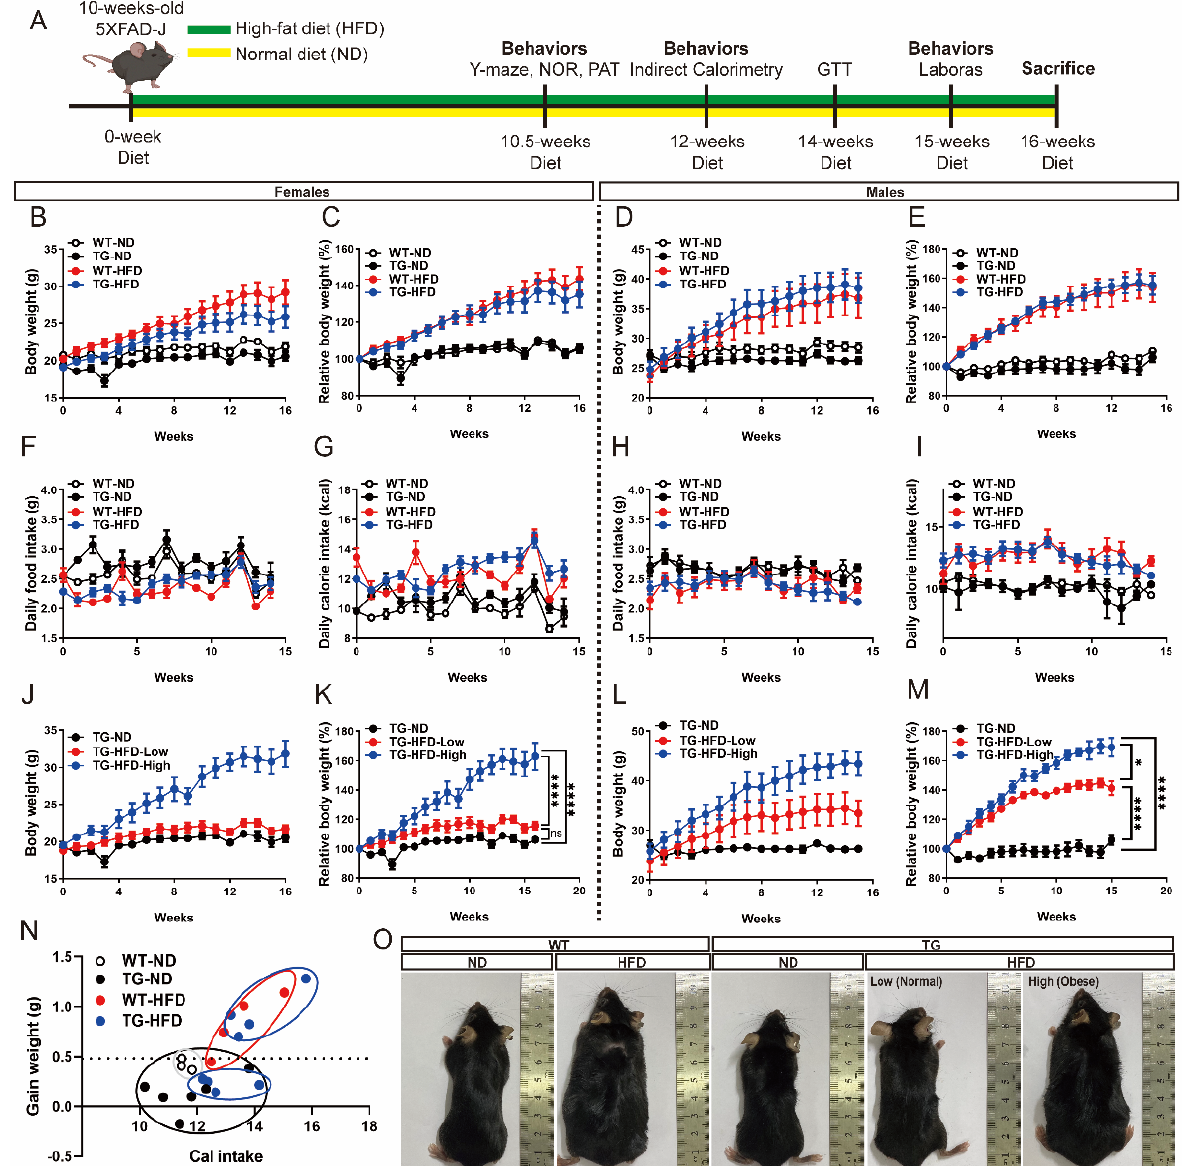
Figure 1. Body weight changes under a high-fat diet (HFD) in the 5XFAD Alzheimer’s disease transgenic mouse model. Experimental scheme ( A ). Weekly measurements of the body weight ( B ), change in body weight ( C ), daily food intake ( D ), and daily calorie intake ( E ) in female mice. Weekly measurements of the body weight ( F ), change in body weight ( G ), daily food intake ( H ), and daily calorie intake ( I ) in male mice. Body weight of the female mice in divided HFD-fed groups ( J ) and change in body weight ( K ). Body weight of the male mice in divided HFD-fed groups ( L ) and change in body weight ( M ). Calorie efficiency chart for weight gain in female mice ( N ). The photographs represent the body shape of the female mice in each group ( O ). ns (not significant), * p < 0.05, and **** p < 0.0001 (one-way analysis of variance with Tukey post hoc analysis). Data are presented as the mean ± standard error of the mean. The number of mice in each group ranged 7 – 12 for females and 4 – 8 for males. ND, normal chow; WT, wildtype; TG transgenic.